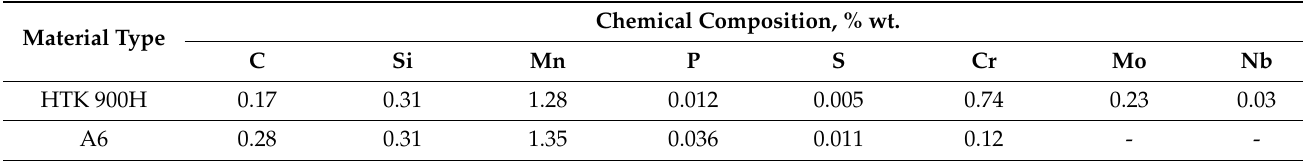
Table 2. Characteristics of HTK 900H and A6 base materials based on the chemical composition analysis. Chemical Composition, % Material Type